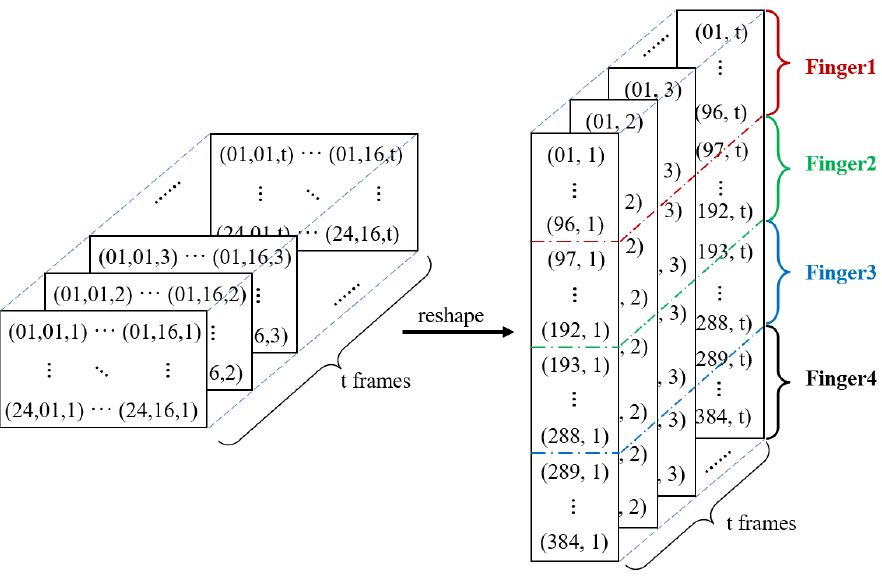
Figure 4. Data-set